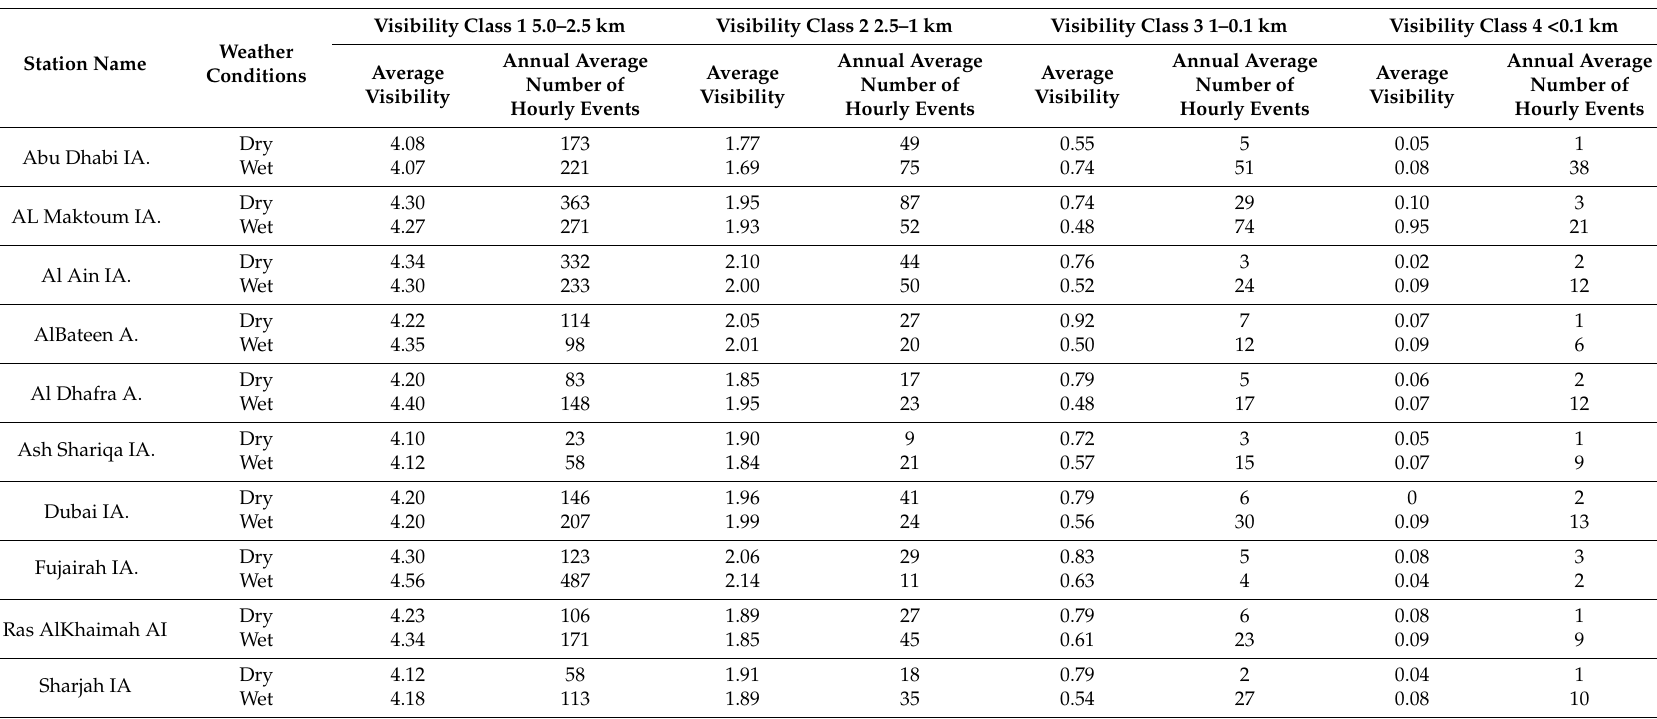
Table 2. Long-term visibility observations averages and average number of hourly events under wet and dry conditions for four classes for ten stations. Bold numbers represent the highest value per